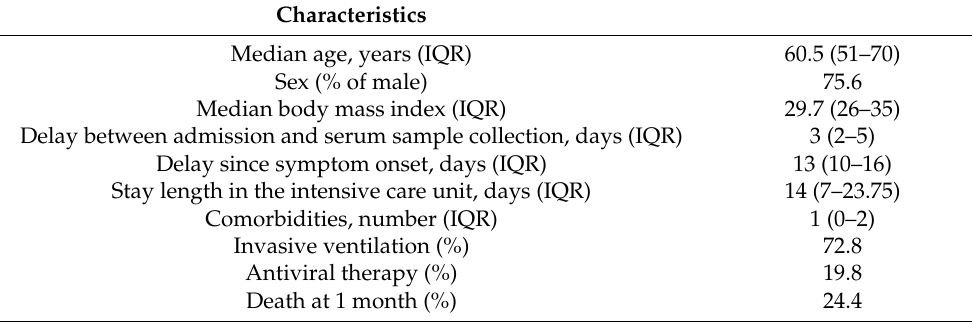
Table 1. Patients’ characteristics.